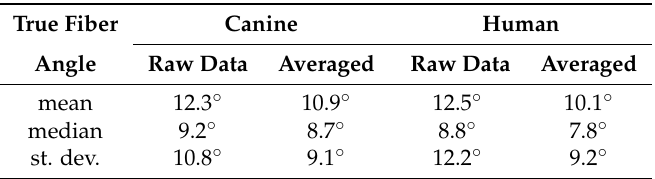
Table 1. Statistics of the error in the true fiber